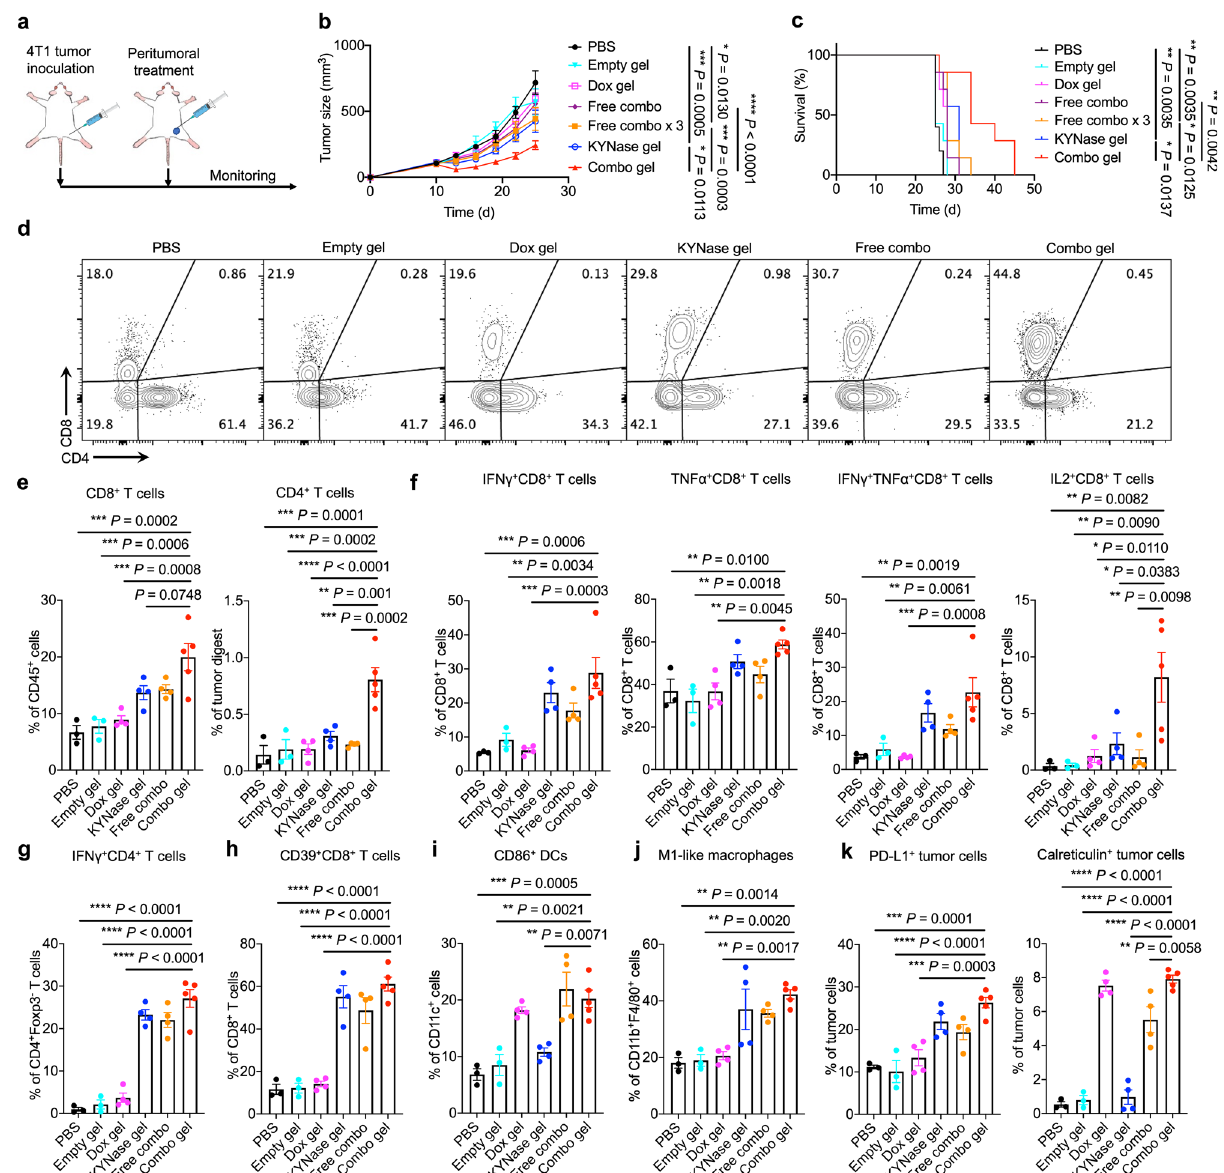
Fig. 3 Hydrogel-enabled local administration of KYNase and Dox in fl ames the TME and suppresses established 4T1 TNBC. a The experimental design. 4T1 cancer cells were implanted subcutaneously on day 0. Mice were treated with empty hydrogel, Dox-loaded hydrogel, KYNase-loaded hydrogel, free KYNase and Dox, free KYNase and Dox administered as 3 doses, or KYNase- and Dox-loaded combination hydrogel on day 10 when tumor volumes reached 100 mm 3 . b Average tumor growth over the course of the study. n = 5 mice for PBS and n = 7 mice for the other groups. c Survival curves for all treatment groups. d – k Following 4T1 tumor inoculation on day 0, different treatments were administered on day 10 when tumor volumes reached 100 mm 3 . Tumors were analyzed 4 days after treatment. n = 3 mice for PBS and empty hydrogel groups, n = 5 mice for the combination hydrogel group, and n = 4 mice for the other groups. d, e , Representative FACS plots ( d ) and quanti fi cation ( e ) of CD8 + and CD4 + TILs. f , g Quanti fi cation of IFN γ + , TNF α + , IFN γ + TNF α + , and IL2 + CD8 + ( f ) and IFN γ + CD4 + ( g ) TILs after ex vivo stimulation. h Quanti fi cation of CD39 + CD8 + TILs. i, j Percentage of CD86 + DCs ( i ) pre-gated on CD45 + CD11c + populations, and M1-like macrophages ( j ) pre-gated on CD45 + CD11b + F4/80 + populations in tumor tissues. k Percentage of PD-L1 + and calreticulin + tumor cells pre-gated on CD45 - populations. Throughout, data are presented as mean ± s.e.m., and statistical signi fi cance was determined by two-way ANOVA with Turkey ’ s post hoc test ( b ), one-way ANOVA with Turkey ’ s post hoc test ( e – k ) or log-rank (Mantel-Cox) test ( c ). Source data are provided as a Source Data fi